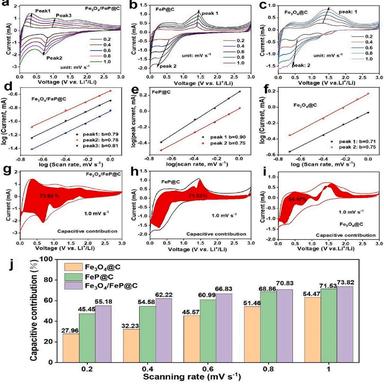
CV curves of Fe3O4/FeP@C (a), FeP@C (b) and Fe3O4@C (c) at different scan rate. Fitting profiles of b-values for Fe3O4/FeP@C (d), FeP@C (e) and Fe3O4@C (f). Capacitive contribution under shaded areas of Fe3O4/FeP@C (g), FeP@C (h) and Fe3O4@C (i). (j) Capacitive contribution for Fe3O4/FeP@C, FeP@C and Fe3O4@C at a scanning rate of 1.0 mV s − 1 .